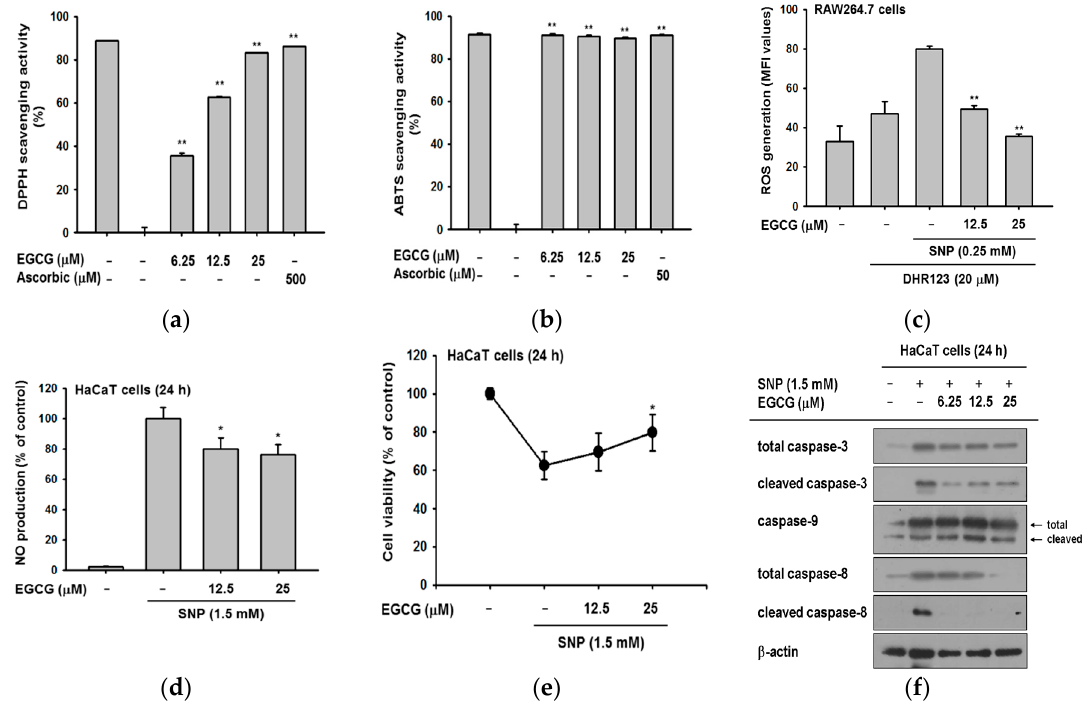
Figure 3. The antioxidative activities of EGCG. ( a ) EGCG (0–25 μ M) was reacted with 2,2-diphenyl-1-picrylhydrazyl (DPPH) in the dark at 37 °C for 30 min. Absorbance at 517 nm was measured by spectrophotometry; ( b ) 2,2’-Azino-bis(3-ethylbenzothiazoline-6-sulphonic acid) (ABTS) and EGCG (0–25 μ M) were incubated together at 37 °C for 30 min. Absorbance at 730 nm was measured by spectrophotometry. Ascorbic acid was used as a control compound; ( c ) RAW264.7 cells (1 × 10 6 cells/well) were treated with dihydrorhodamine 123 (DHR123) (20 μ M) in the dark at 37 °C for 10 min. Cells were treated with EGCG (0–25 μ M) for 20 min, and incubated additionally with sodium nitroprusside (SNP). The ROS level was determined by flowcytometric analysis; ( d ) HaCaT cells were pretreated with EGCG and then exposed to SNP for 24 h. SNP-derived NO production was analyzed by Griess assay; ( e ) the viability of SNP-treated cells was determined by an MTT assay; ( f ) HaCaT cells were incubated with EGCG and SNP for 24 h. Cleaved and total forms of caspases and β -actin expression were determined by immunoblotting. Statistical significance of results ( a – e ) was evaluated by Kruskal–Wallis/Mann–Whitney test. All data are expressed as means ± SD of an experiment. * p < 0.05 and ** p < 0.01 compared with control group.